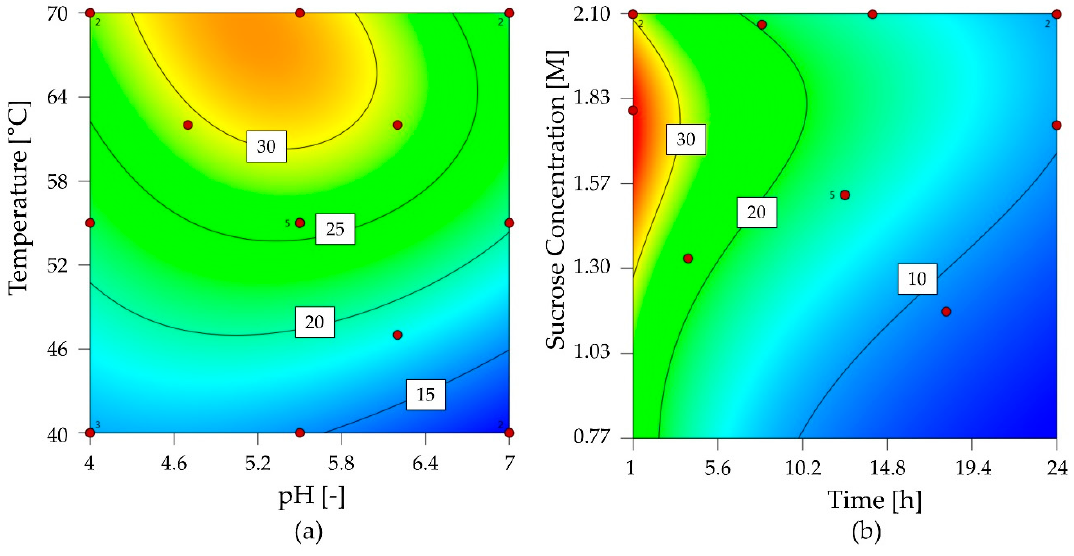
Figure 6. Contour plot of 6-SFT activity to determine the total activity [U mL − 1 ] using a 3.2 × concentrated supernatant solution. ( a ) Total activity [U mL − 1 ] as a function of pH and temperature (2 h reaction time, 1.71 M sucrose). ( b ) Total activity [U mL − 1 ] as a function of time and sucrose concentration (pH 5.8, 70 °C).